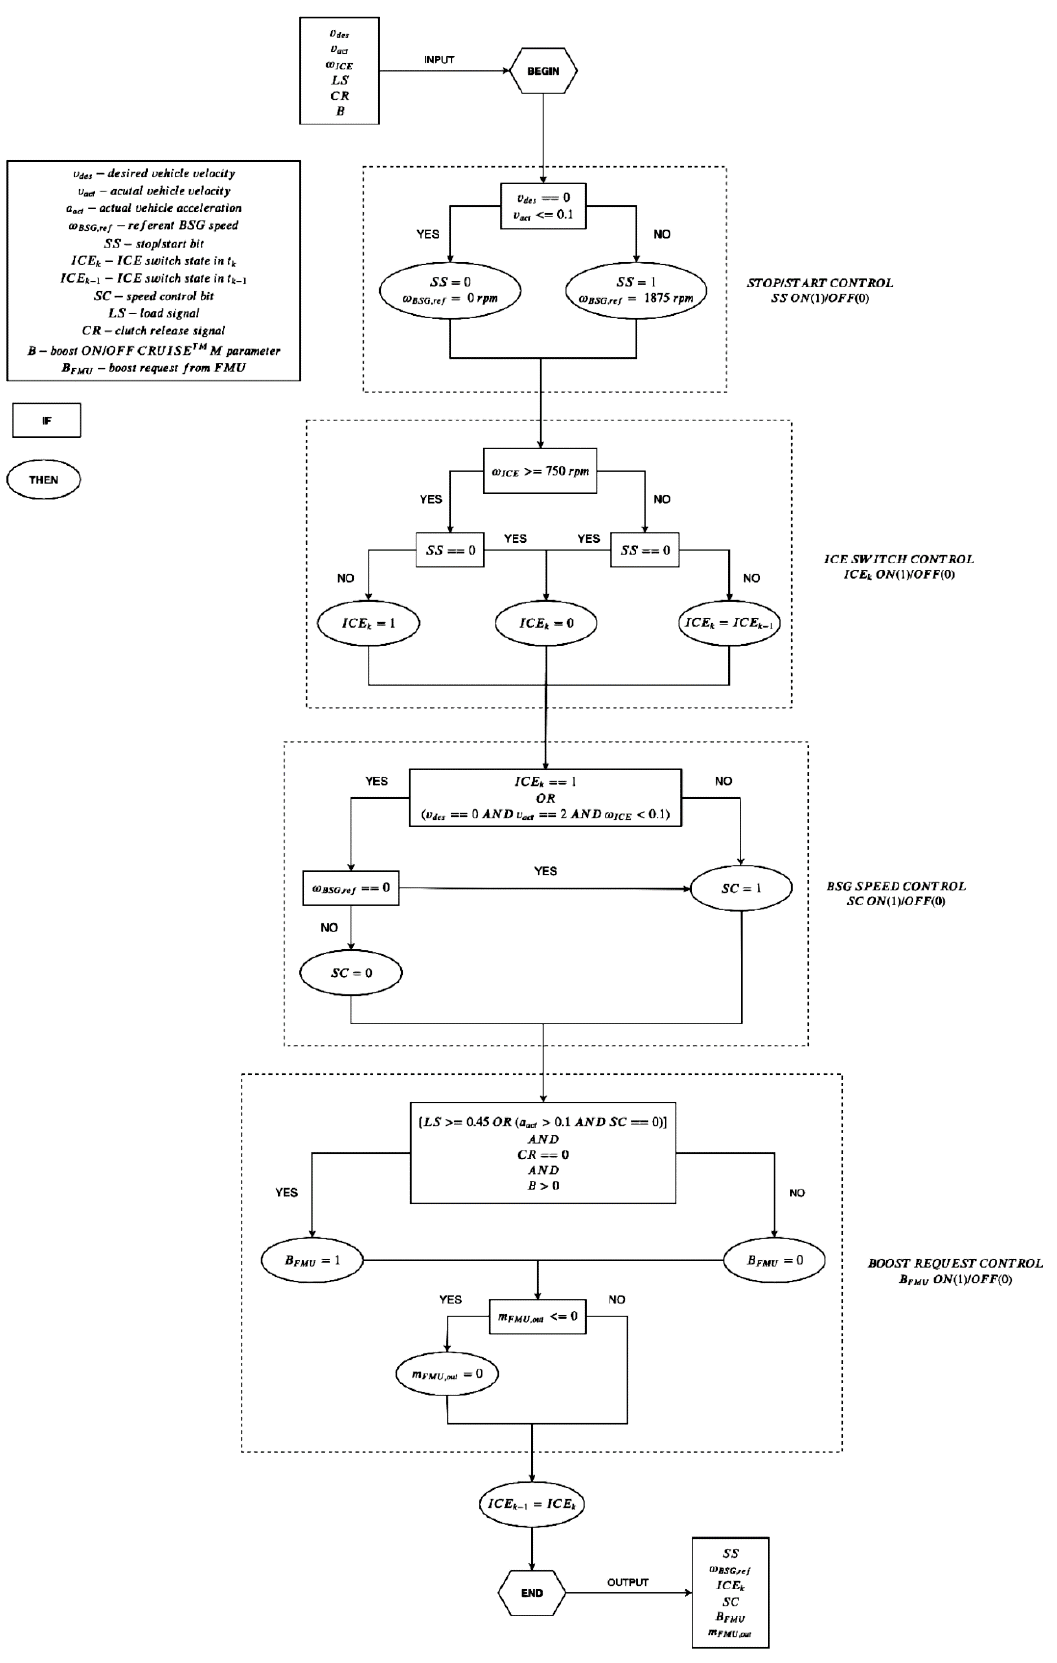
Figure 13. Stop/start and torque boost control logic flowchart [10].